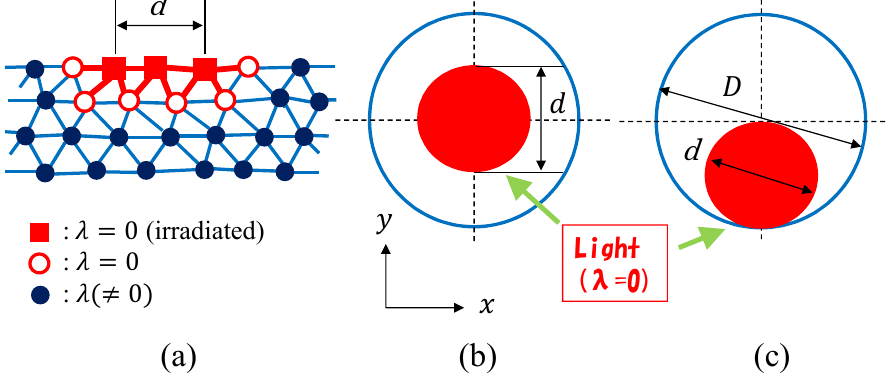
Figure 4. ( a ) An illustration of irradiated vertices, their neighboring vertices and non-irradiated vertices at a section of the disk lattice, ( b , c ) top view of irradiated disks, where the ratio d / D = 0.5 and the center of irradiated domain in ( b ) are di ff erent from those in ( c